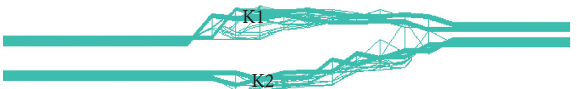
Figure 5: Grid diagram of boundary line of K1 ore body and K2 ore body (front